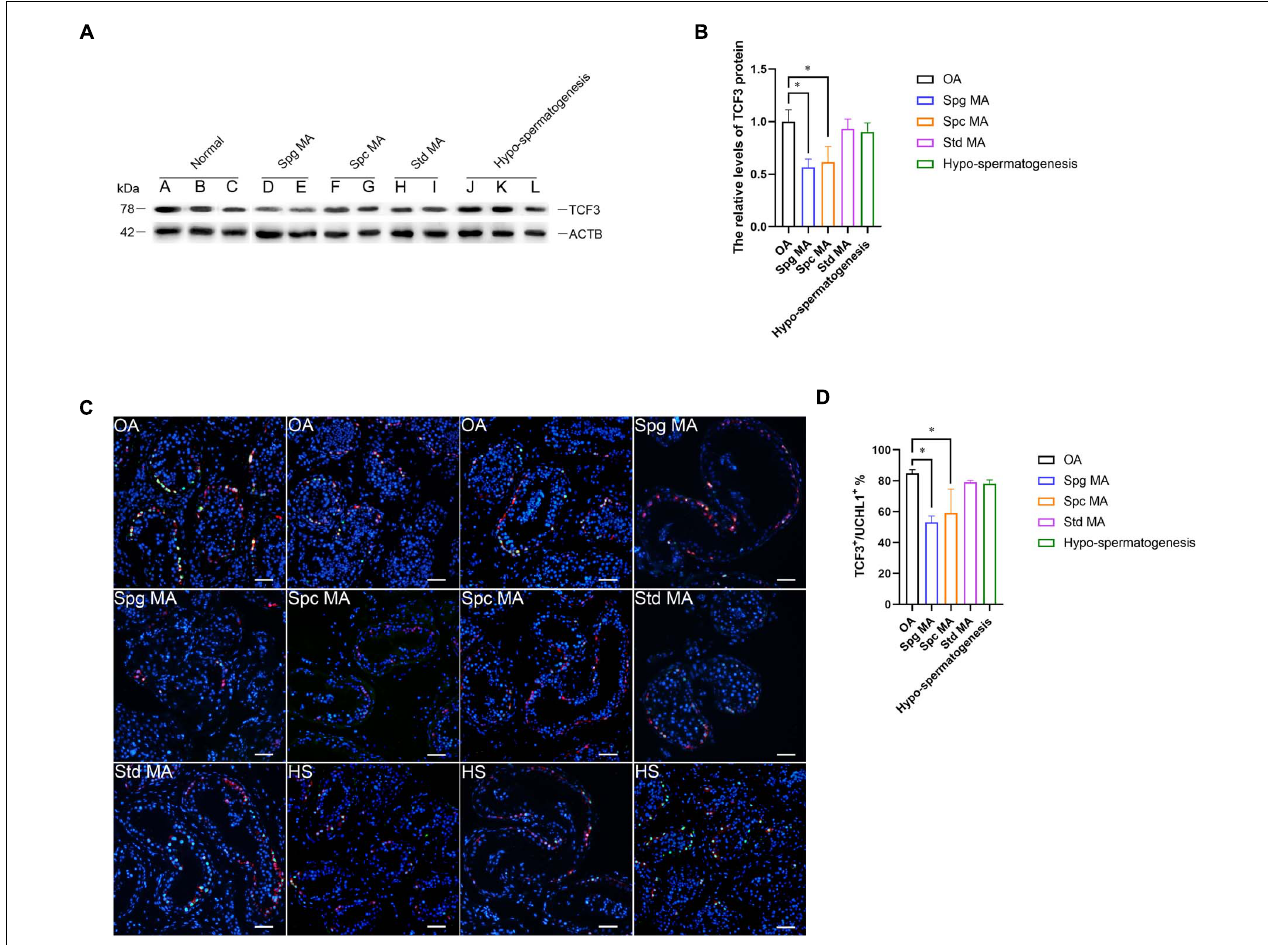
FIGURE 7 | The expression of TCF3 in the testis of OA patients and NOA patients. (A,B) Western blotting compared the levels of TCF3 protein between OA and NOA patients. Notes in (A) : sample A, B, and C were individuals with OA with normal spermatogenesis; sample D and E were NOA patients with Spg MA; sample F and G were NOA patients with Spc MA; sample H and I were NOA patients with Std MA; and sample J, K, and L were NOA patients with HS. (C,D) The percentages of UCHL-positive SSCs with TCF3 expression between OA and various kinds of NOA patients. Scale bars: (C) , 100 µ m. * p < 0.05 indicated the significant differences between OA patients with normal spermatogenesis and NOA